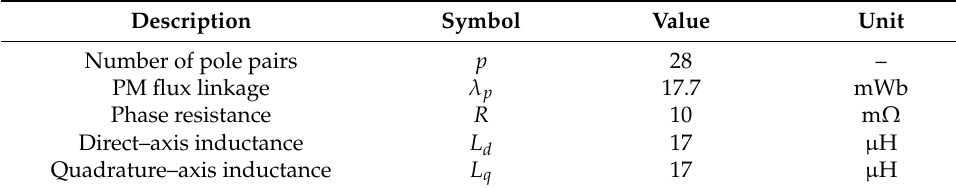
Table 1. In–wheel motor electrical